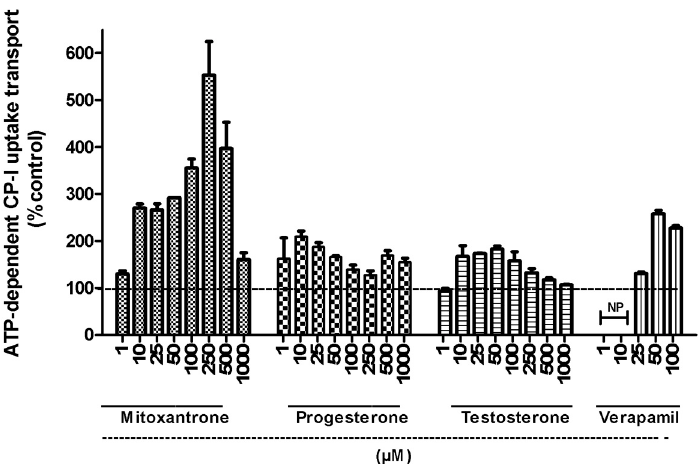
Figure 2. Effect of various modulators (mitoxantrone, progesterone, testosterone, and verapamil) on the uptake of CP-I in rat Mrp2 membrane vesicles. Rat Mrp2-mediated CP-I transport was measured in inside-out membrane vesicles. Mrp2 vesicle protein (50 µg/well) were preincubated with modulators at above reported concentrations at 37 °C and reaction was started by adding CP-I (5 µM) and incubated for 15 min. NP; not performed. For more on experimental details refer to Section 2.3. Dotted line represents basal level (100%) of CP-I uptake in control wells in the presence of ATP with no modulators added. All data values presented as mean and SD of single experiment performed in triplicate wells. In the inset, same data set is represented in curve to show the bell shape of the concentration-dependent stimulation and inhibition (also referred as modulation in the text).